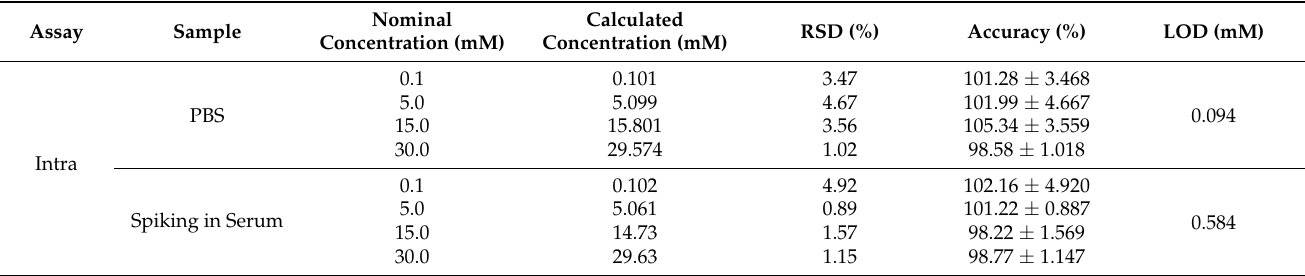
Table 2. Determination of glucose onto Ru(dmo–bpy) 2 Cl 2 /GDH/PDA-MWCNT/SPCEs and validation using MPS from the PBS and spiked serum sample ( n =